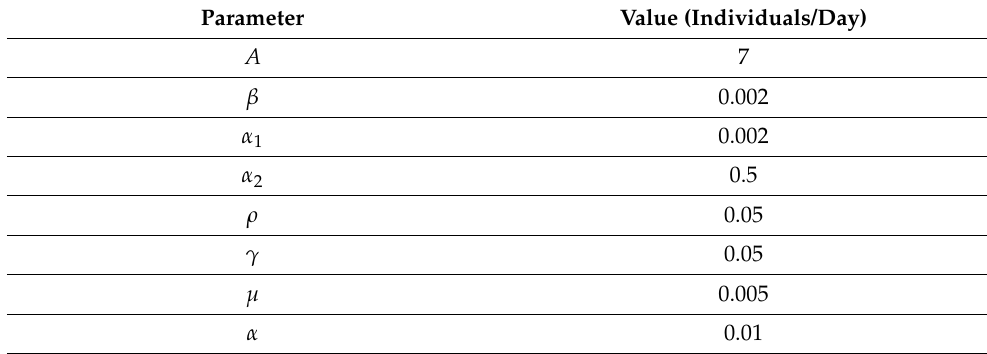
Table 1. Parameters for the models (1)–(3) employed in the simulation examples.